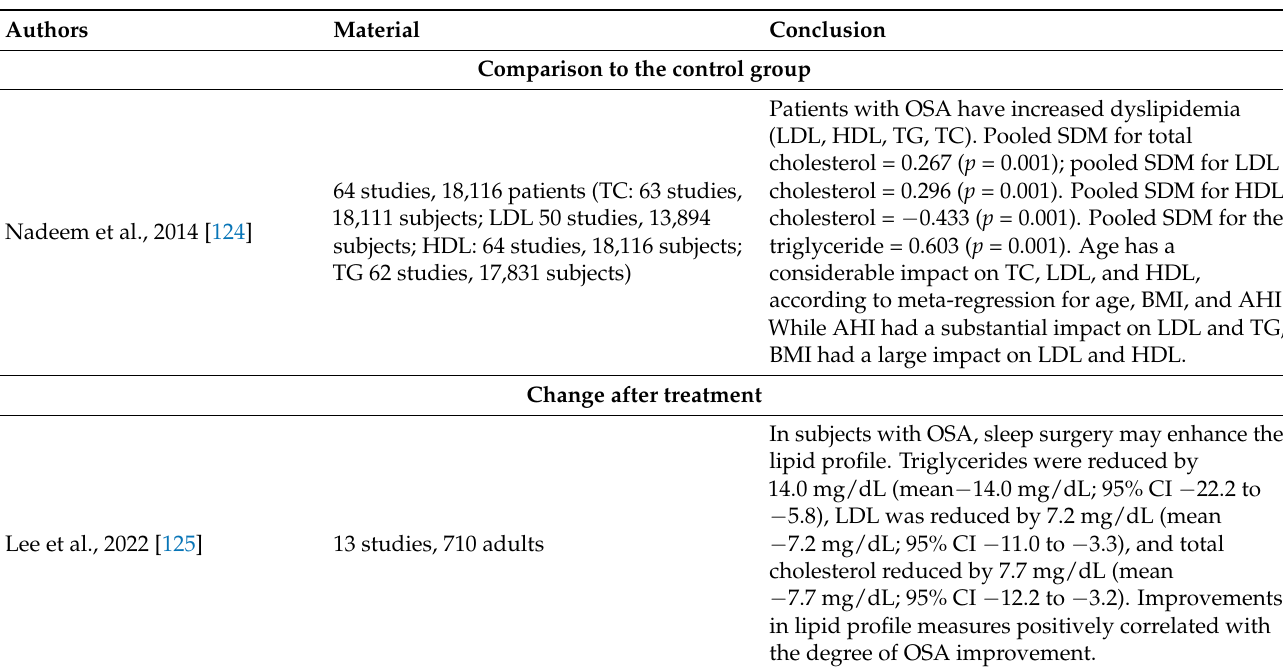
Table 14. Meta-analyses of lipid profile studies in OSA